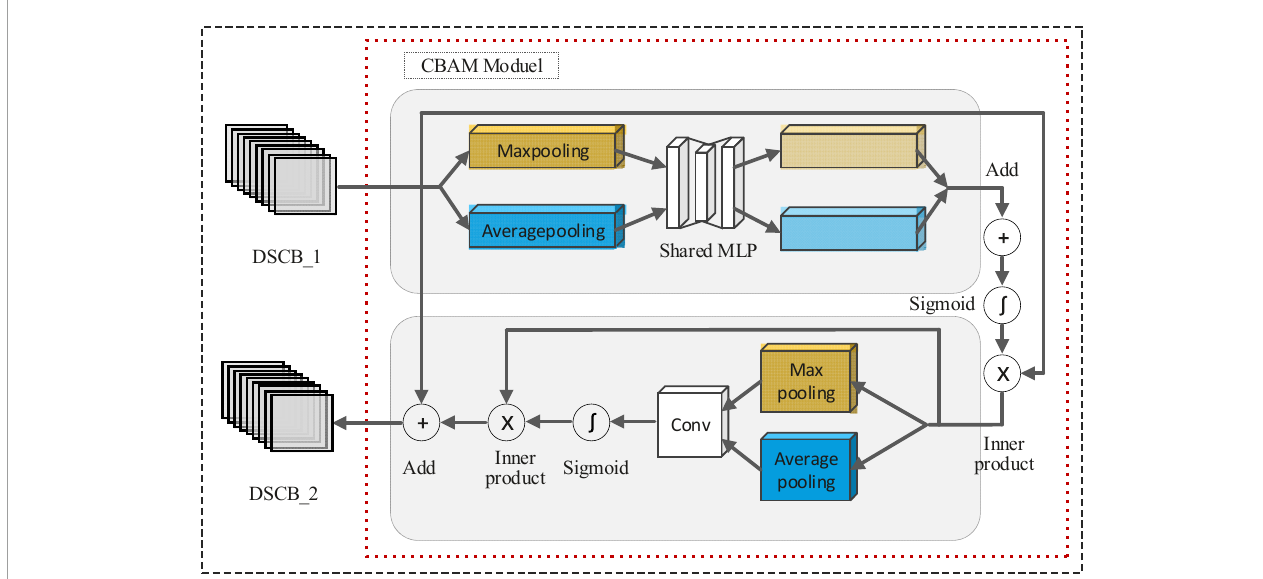
FIGURE6 CBAM structure diagram.